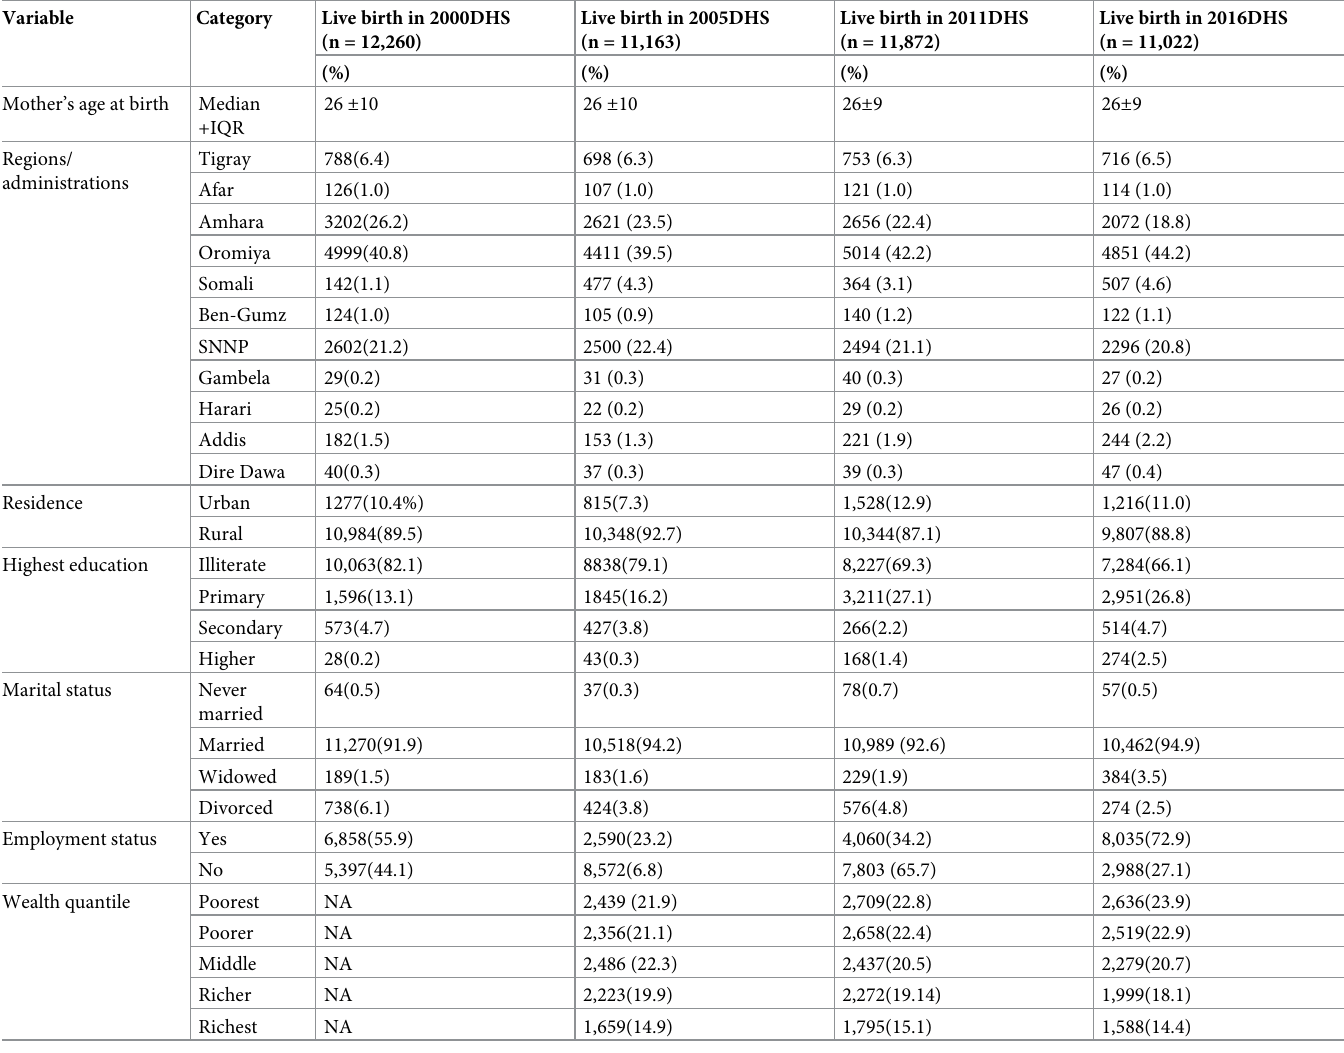
Table 1. Sociodemographic and economic characteristics of the study population, finding from 2000 to 2016 DHS.